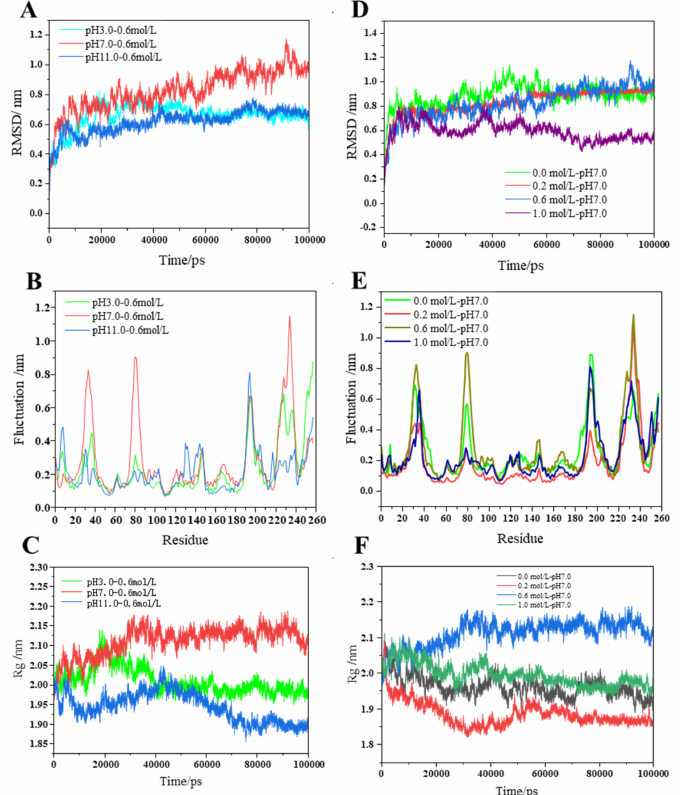
Figure 2. Structural behavior indicators over simulation time: ( A ) RMSD variation of apo structure heavy atoms; ( B ) RMSF of apo structure heavy atoms; ( C ) radius of gyration of apo structure; ( D ) RMSD variation of holo-structure heavy atoms; ( E ) RMSF of holo-structure heavy atoms; and ( F ) radius of gyration of holo-structure. RMSF x-axes denote i. the secondary structures, ii. the sub- domains, and iii. the disulfide bridges. The 4 ◦ C systems are depicted with black lines; 25 ◦ C systems are depicted with red lines; and 75 ◦ C systems are depicted with green lines. (For interpretation of the references to color in this figure legend, the reader is referred to the web version of this